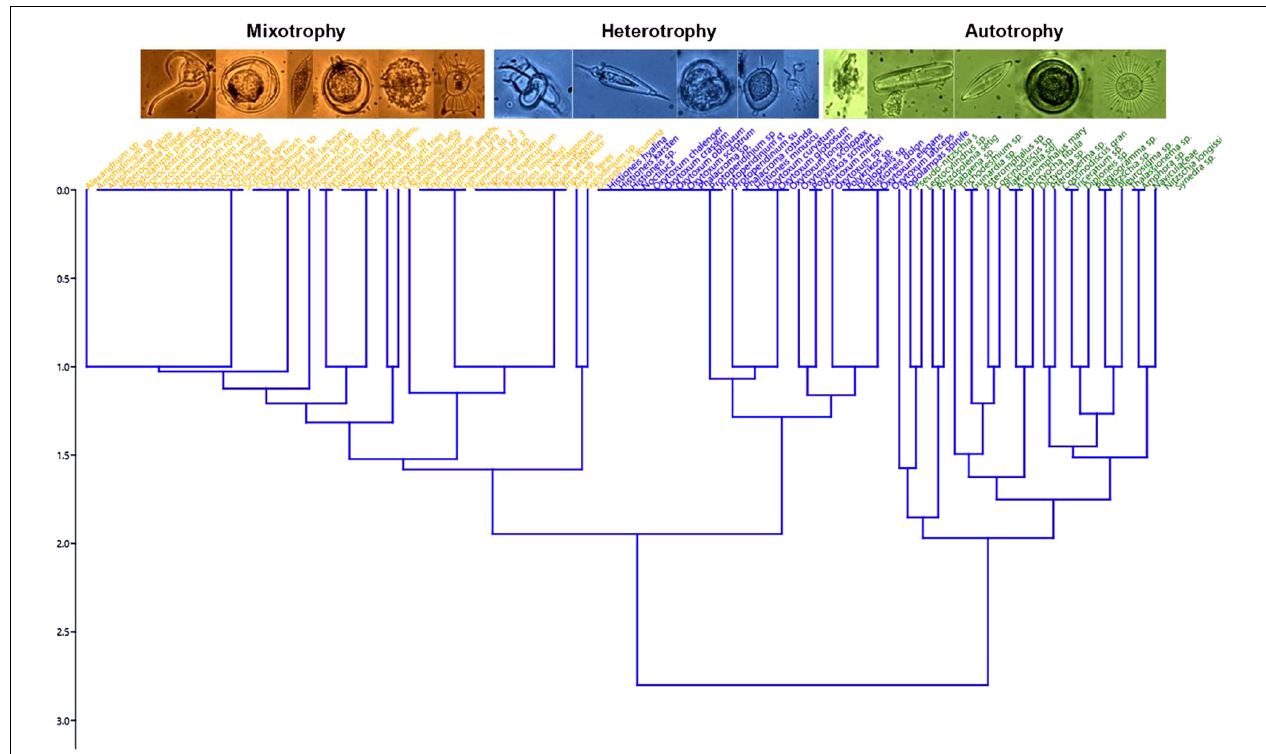
FIGURE 4 | Dendrogram from the functional traits of